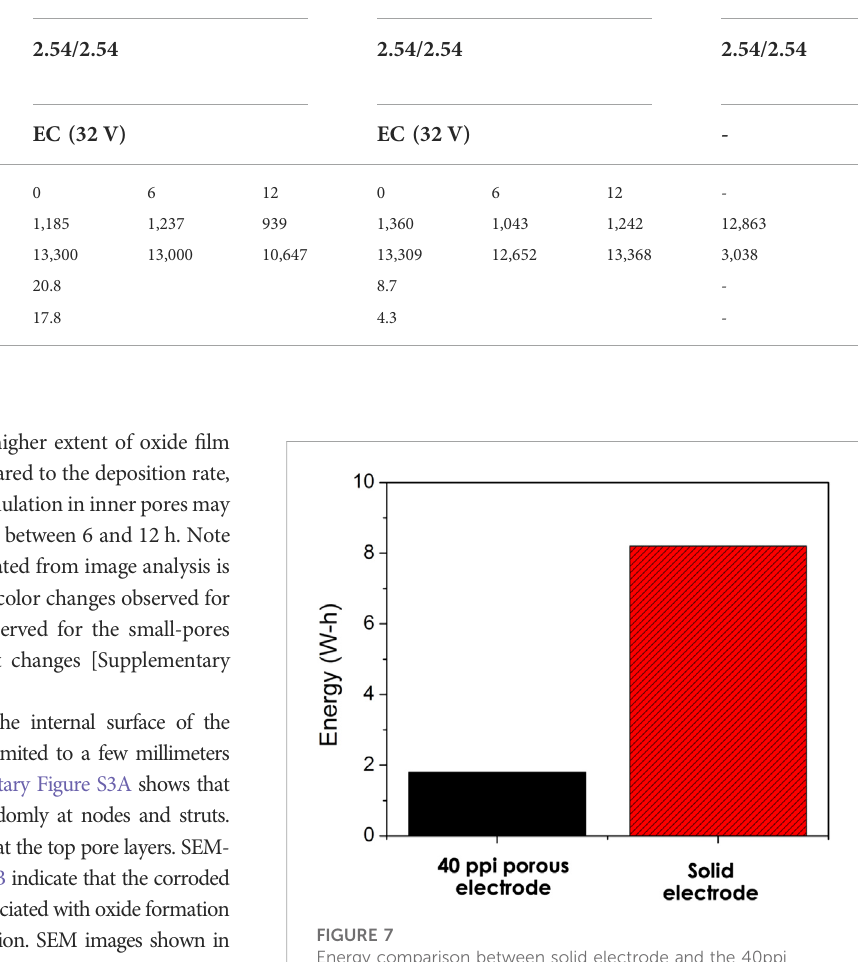
TABLE 2 Characteristics of porous Al foam electrodes corresponding to Figure 6. Al foam (anode) Al foam (cathode) Solid